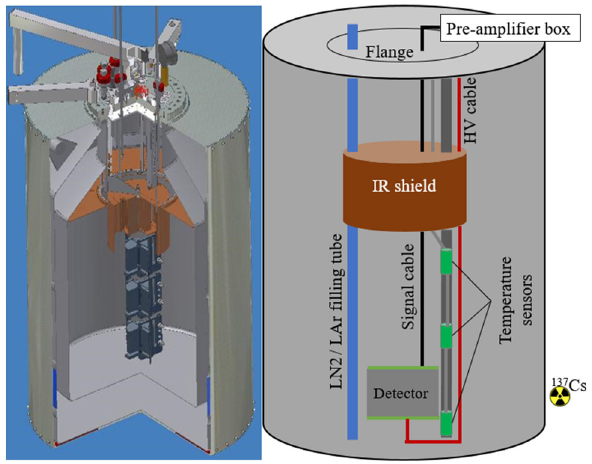
Fig. 6 Left: technical drawing of the MPI cryostat. Right: schematics of its internal wiring